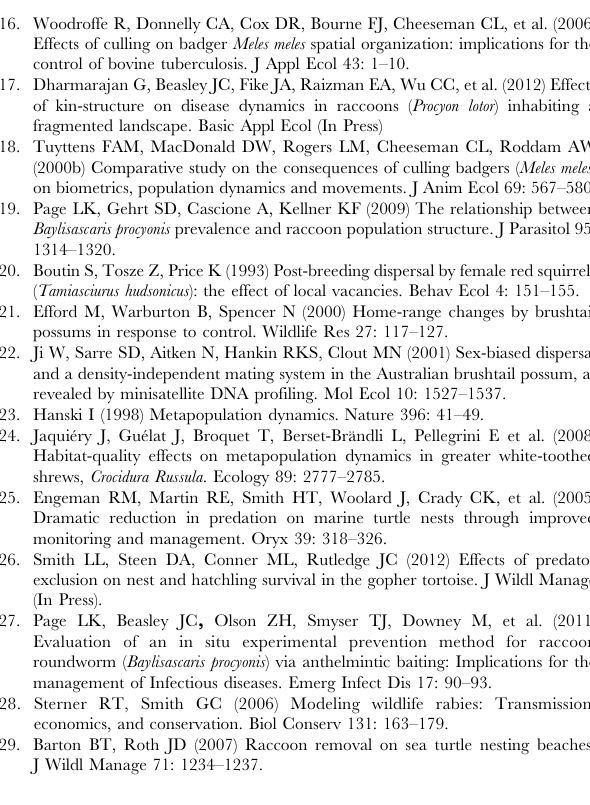
Table S2 Summary information for each of the 30 experimental forest patches used in this study which were distributed throughout the upper Wabash river basin in northern Indiana, USA. Patches were depopulated of raccoons in 2007 and then allowed to naturally recolonize. Experimental patches were assigned to 3 isolation classes (estimated using the PROX function in FRAGSTATS) based on the distribution of isolation values observed in our study area: 1) highly isolated patches, 2) intermediate—clusters of patches varying in proximity to one another, and 3) connected— mainland-island systems). Density estimates for each year are based on population sizes estimated using the Huggins closed capture-recapture modeling procedure in Program MARK, incorporating a buffer encompassing an area equal to the average raccoon home range size in our study area (73 ha) to account for raccoon movements. Estimates of female abundance were derived using the Huggins closed capture-recapture modeling procedure in Program